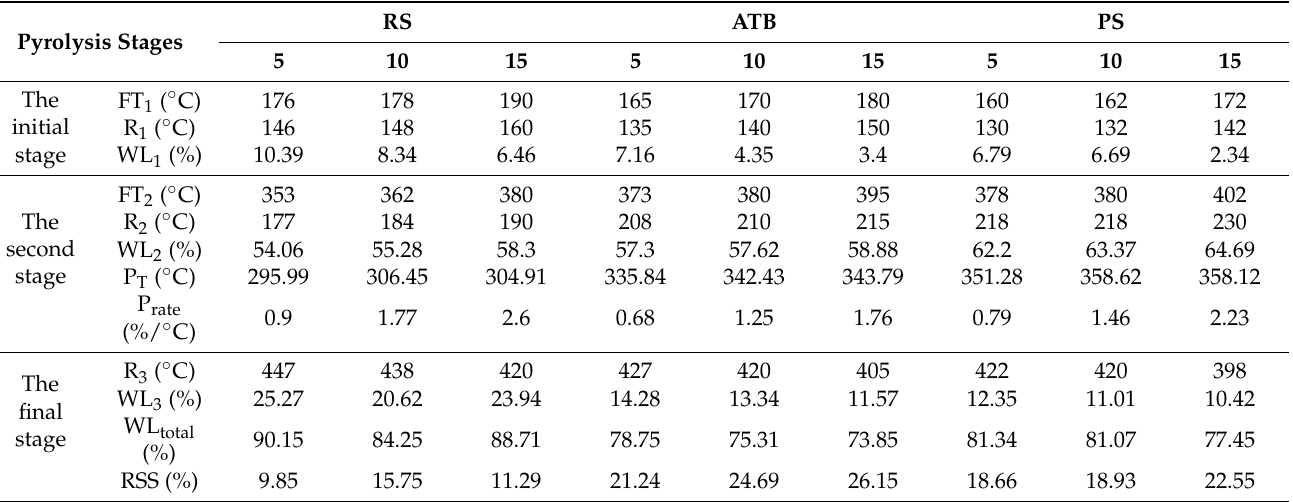
Table 4. Characteristic temperatures associated with the mass losses in different stages of decomposi- tion during the pyrolysis of RS, ATB, and PS at a different heating rates ( ◦ C · min − 1